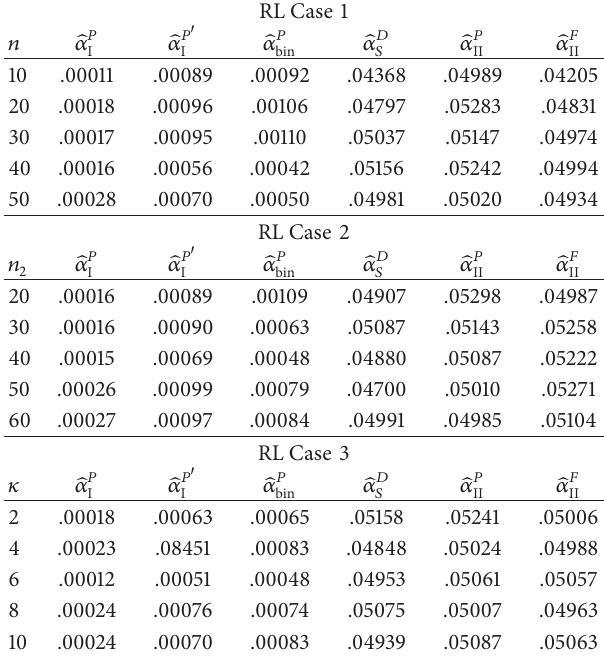
Table 5: The empirical significance levels of the tests under RL = 1000 for each of 100 background realization Cases 1–3 with 𝑁 mc at 𝛼 = .05 . The empirical size labeling is as in Table 3. ̂𝛼 𝐹 the empirical size estimates of the exact tests for Pielou’s second type of symmetry (the table exclusive